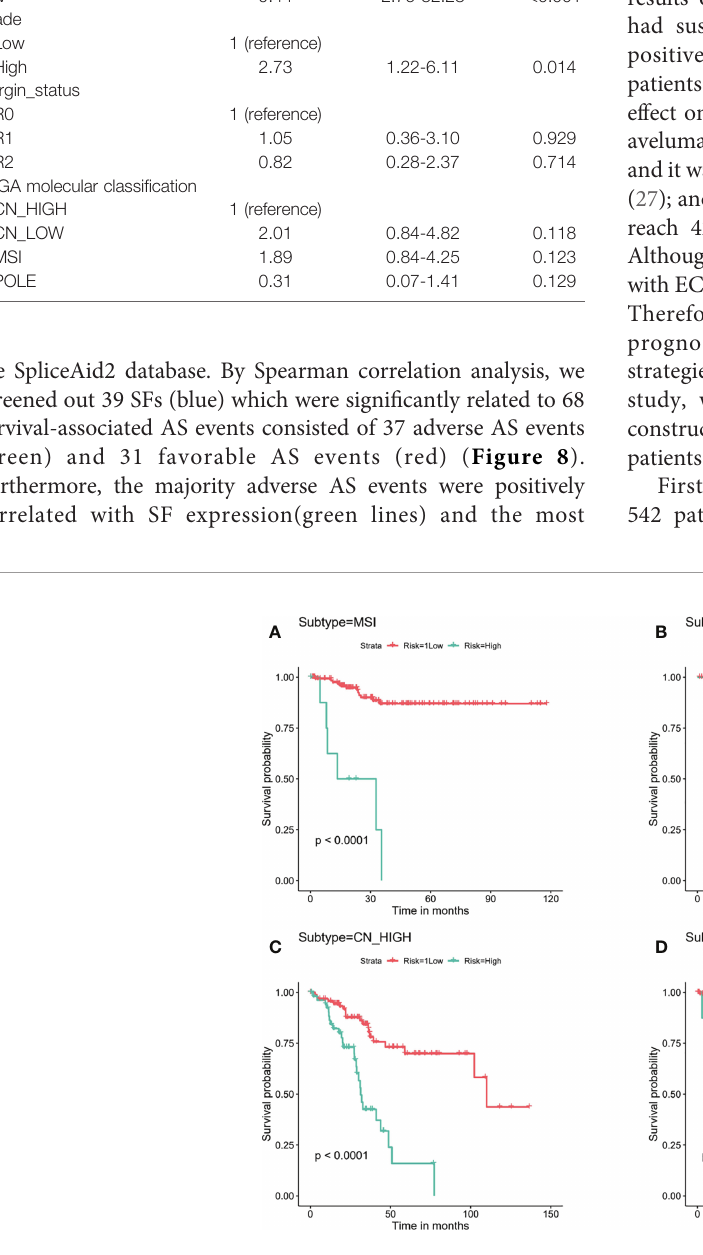
FIGURE 6 | Strati fi ed analysis for the prognostic risk model in the different subgroups according to TCGA molecular classi fi cations. (A) MSI, (B) POLE, (C) CN-HIGH, (D)